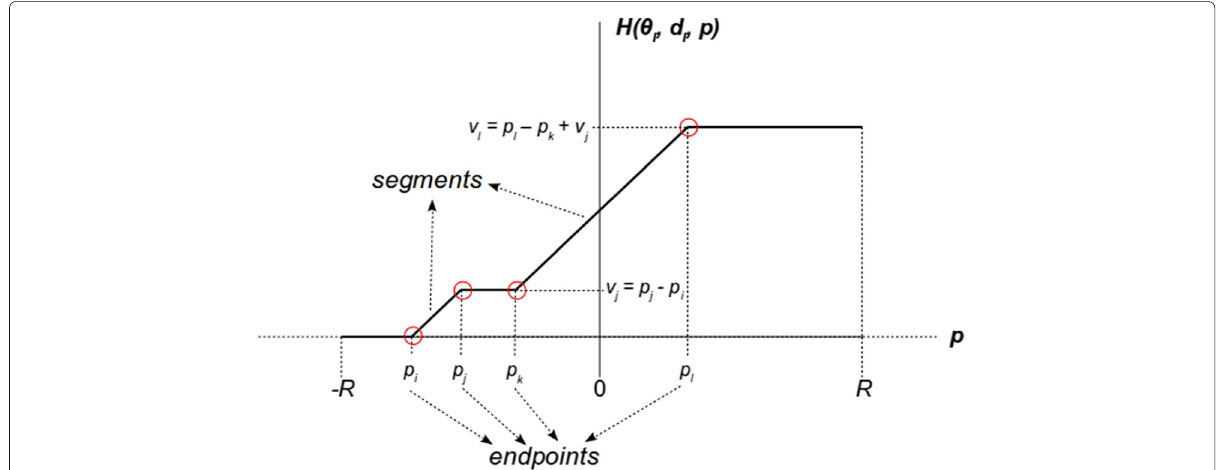
Fig. 3 Representation of two segments of a line l ( d l , θ l ) in the 3D Hough